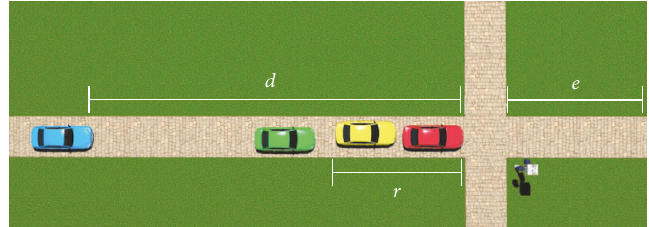
Figure 4: Rule 1 attempts to turn a red light green when many vehicles approach it. Rule 2 prevents fast switching of traffic lights for high densities and also prevents a street from having always a green light. Rule 3 prevents “tails” of platoons from being cut, promoting the integrity of platoons. Rule 4 allows a quick change of lights at low densities, as isolated vehicles can activate the lights change as they approach an intersection without requiring them to form platoon. Rules 5 and 6 prevent gridlocks caused by stationary vehicles at intersections, while allowing flow in directions with space